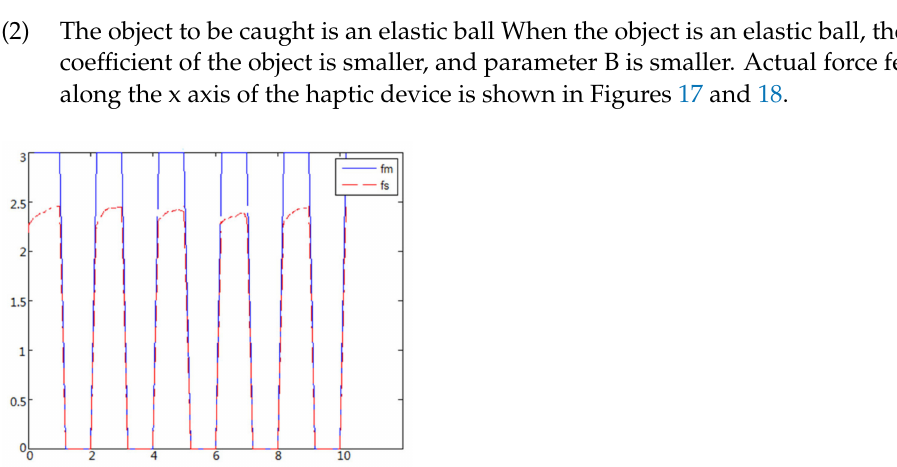
Figure 16. Force feedback along x axis. (Constant time delay).